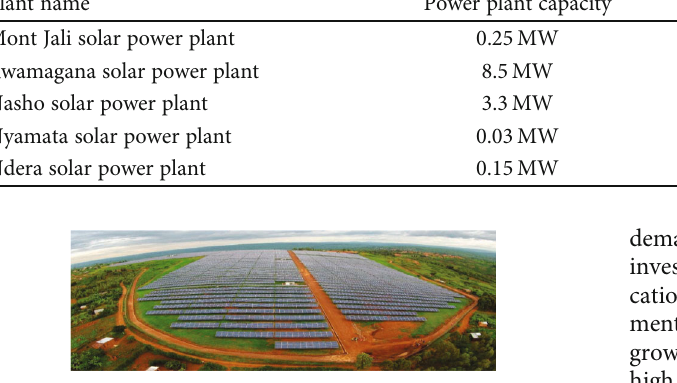
Figure 12: The Rwamagana solar power station